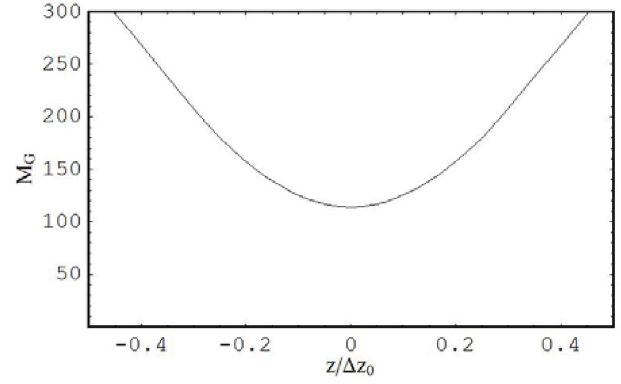
FIG. 4. Gain length at various distances within the microbunch calculated using fitting formula from Ref. [18].